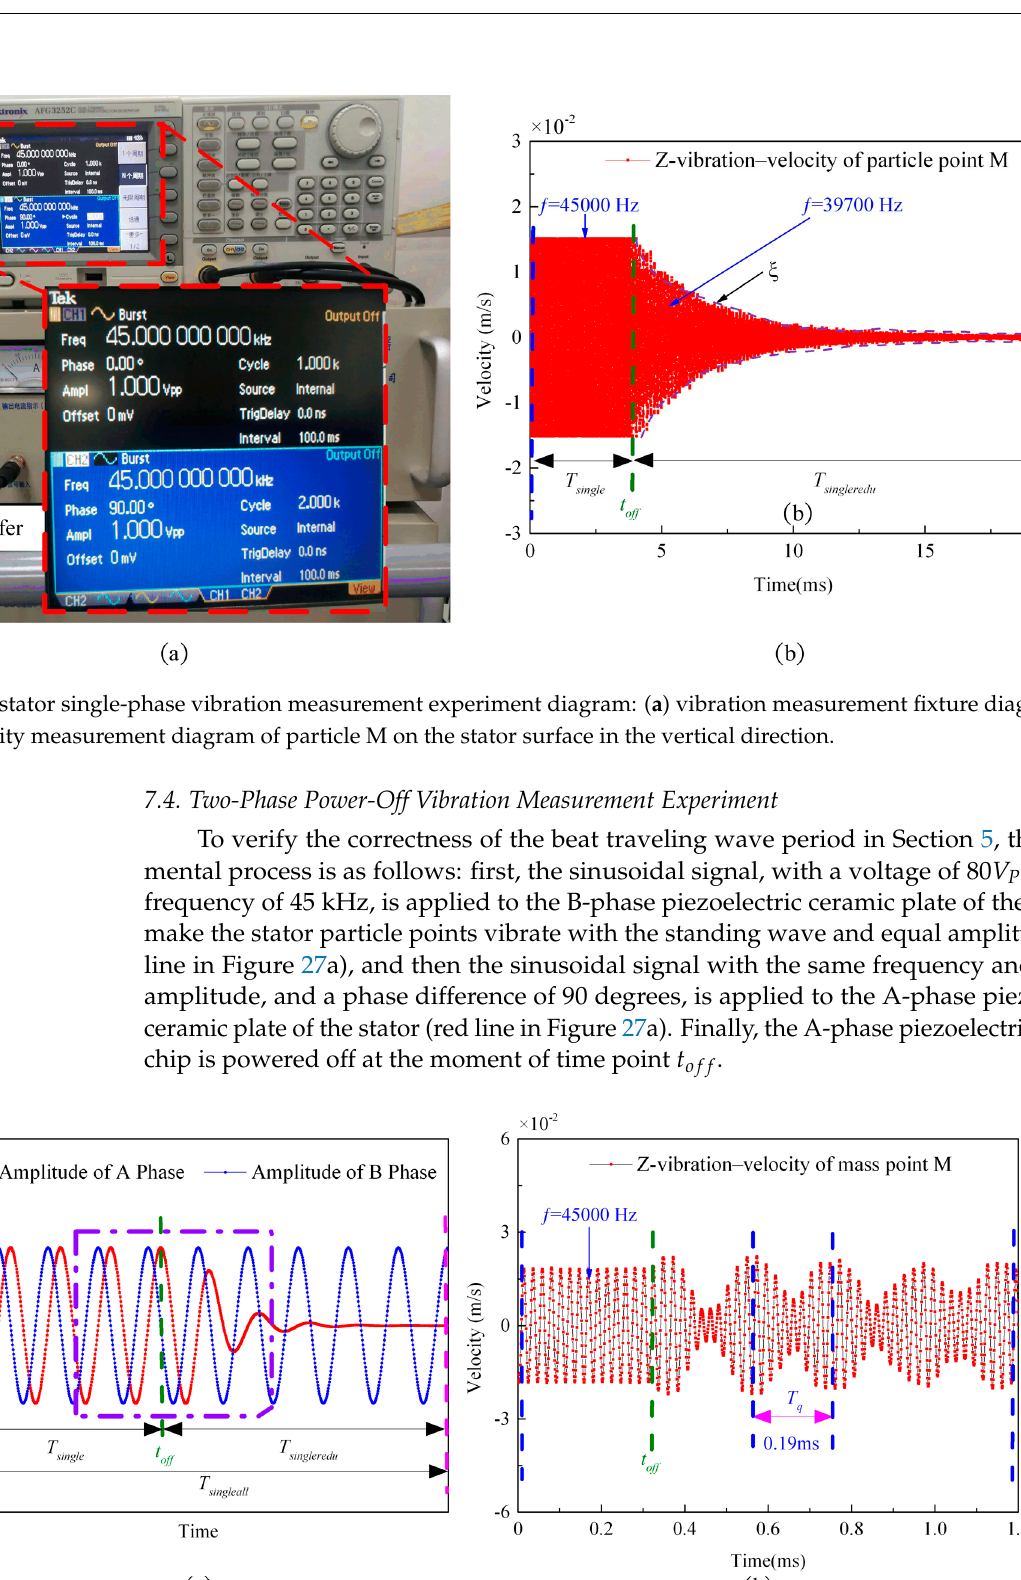
experiment: ( a ) a schematic diagram of the two-phase excitation response; and ( b ) a measurement diagram of the vertical velocity of particle point M on the stator